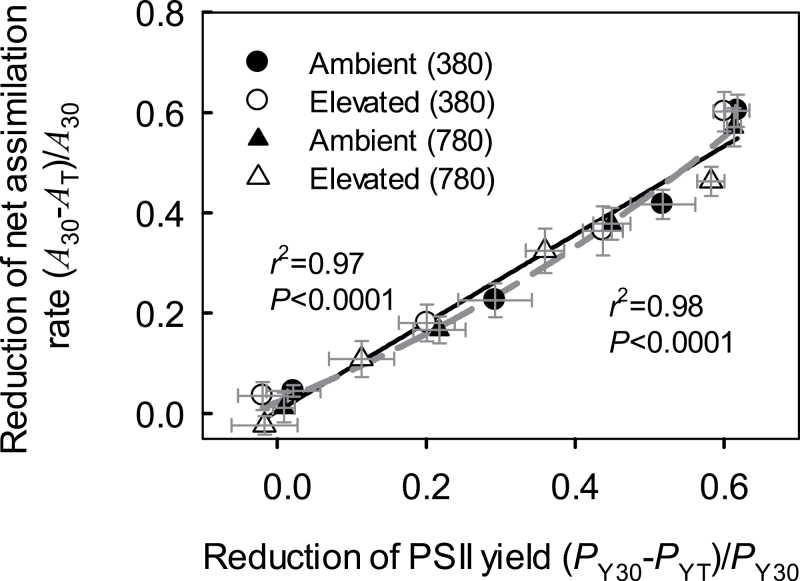
Relationship of the decrease of net assimilation rate (Eq. 2) with the reduction in effective quantum yield of PSII over the temperature range of 30–50 °C (n=8–10 for individual data points). Temperature responses of the change in net assimilation rate are illustrated in Figure 4a, c. The measurements conducted at light intensities of 500 and 2000 μmol m−2 s−1 were pooled. The decrease of PSII quantum yield was calculated as (Y
30−Y
T)/Y
30, where Y
30 is the yield at 30 °C and Y
T the PSII yield at any other measurement temperature between 30 and 50 °C. Error bars denote ±SE. Data were fitted by linear regression.